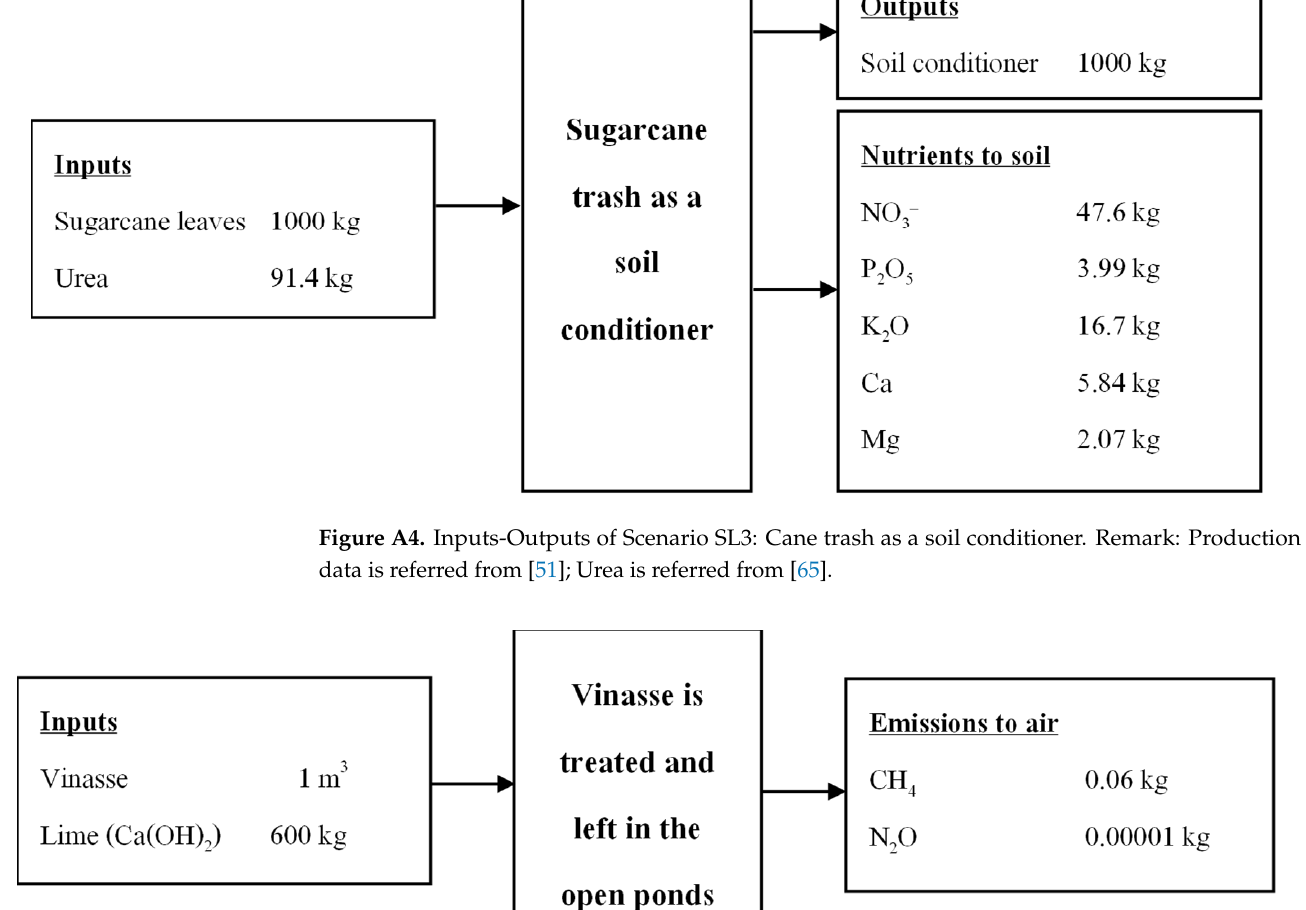
Figure A3. Inputs-Outputs of Scenario SL2: Cane trash to biochar. Remark: Data is referred from [50].